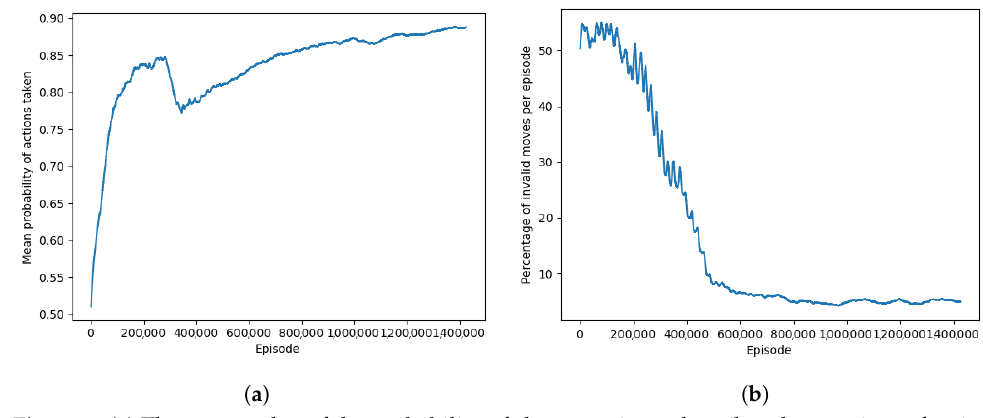
Figure 6. ( a ) The mean value of the probability of chosen action—describes the certainty of action taking decisions of the actor. ( b ) The percentage of invalid moves in the episode. The slope decrease clearly visualise steady progress in the decision-making process while still remaining slightly high due to non-deterministic